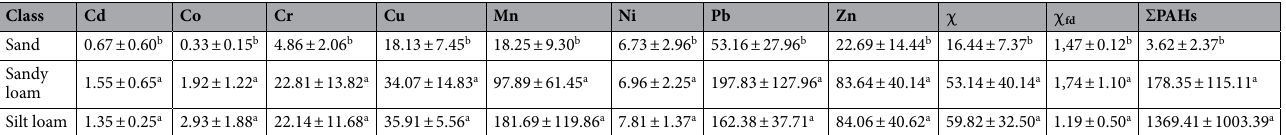
Table 4. Heavy metals content, magnetic susceptibility and PAHs content in soils. Mean ± standard deviation; χ —mass magnetic susceptibility (10 –8 m 3 /kg); χ fd (%)—frequency-dependent magnetic susceptibility; Cd,